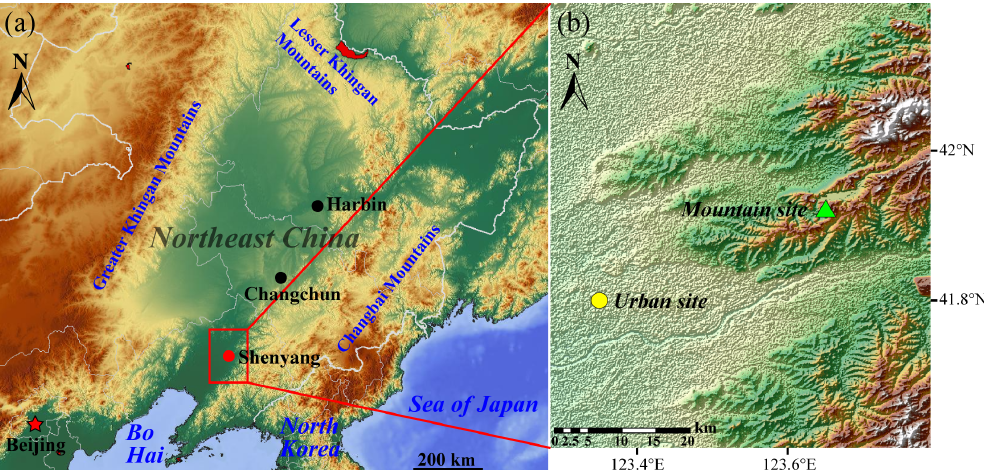
Figure 1. (a) Topographic features of northeast China, which is surrounded by the Greater Khingan Mountains, the Lesser Khingan Moun- tains, and the Changbai Mountains. (b) Locations of the urban and mountain sites. The relief map in (a) is from © OpenStreetMap contributors 2019 distributed under a Creative Commons BY-SA License (https://maps-for-free.com/, last access: 20 March